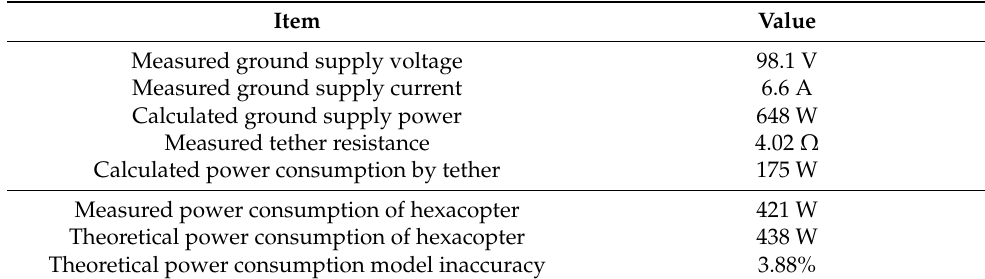
Table 5. Endurance test data and data from